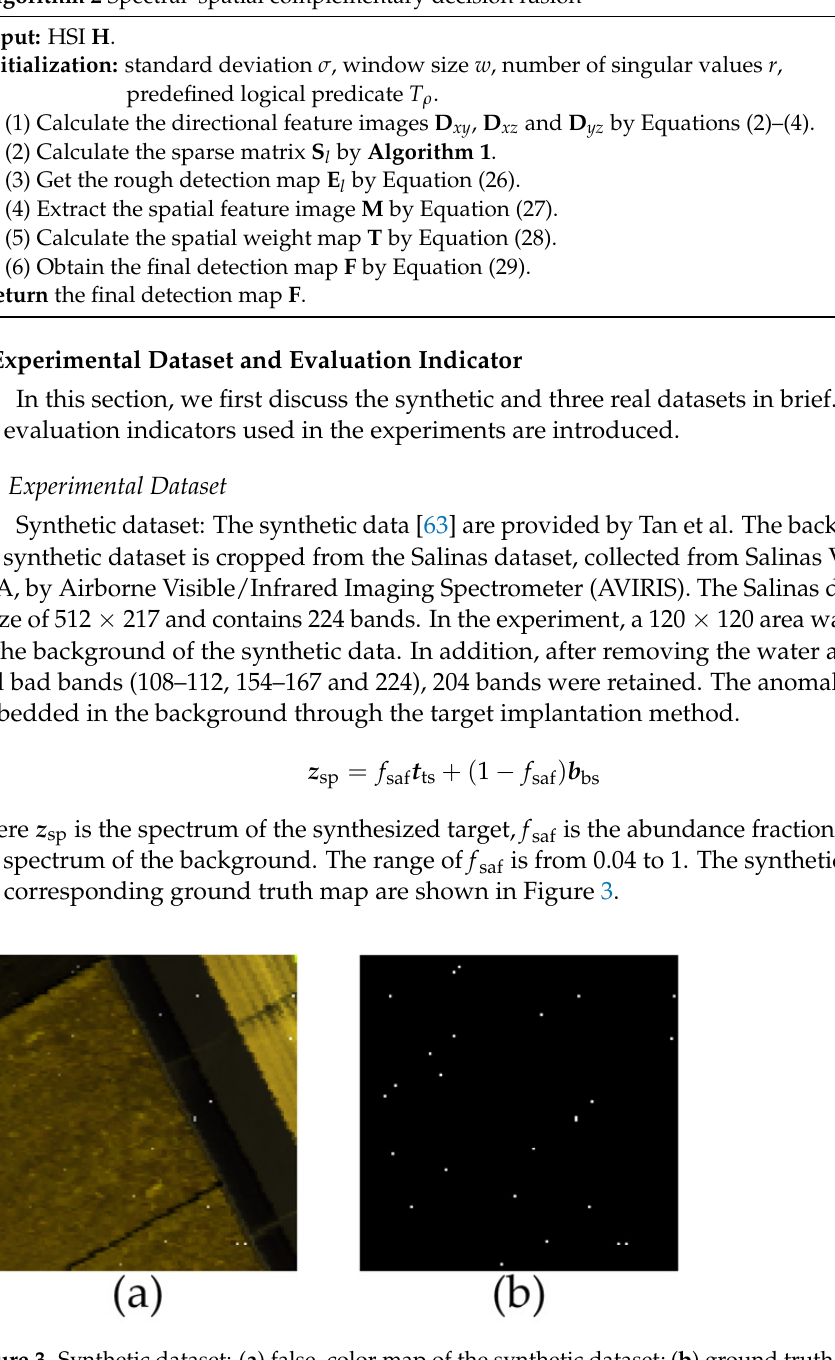
Figure 3. Synthetic dataset: ( a ) false–color map of the synthetic dataset; ( b ) ground truth map of the synthetic dataset.